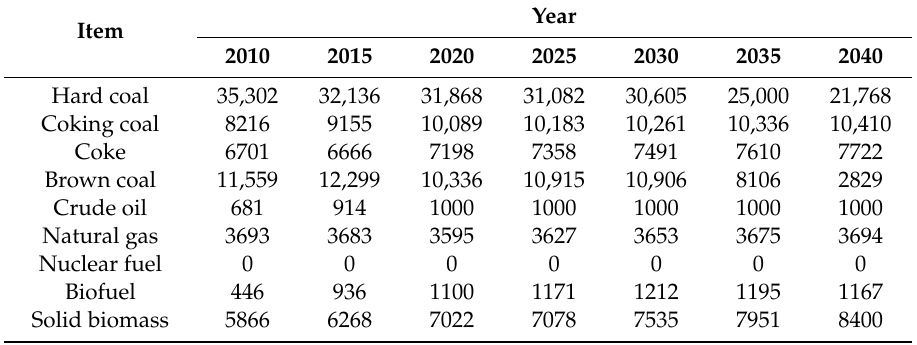
Table 4. Domestic production of individual fuels and energy carriers in the perspective up to 2040, ktoe 1 .